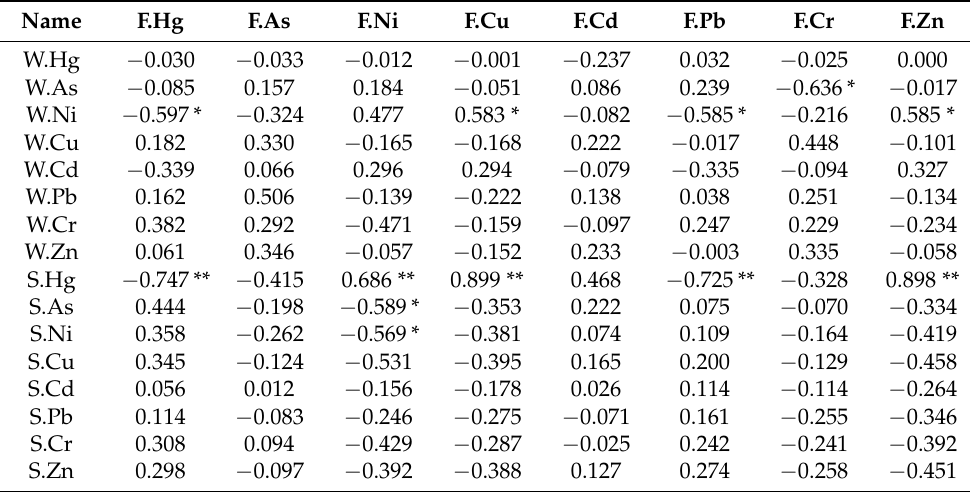
Table 4. Correlation between HMs in fish and water